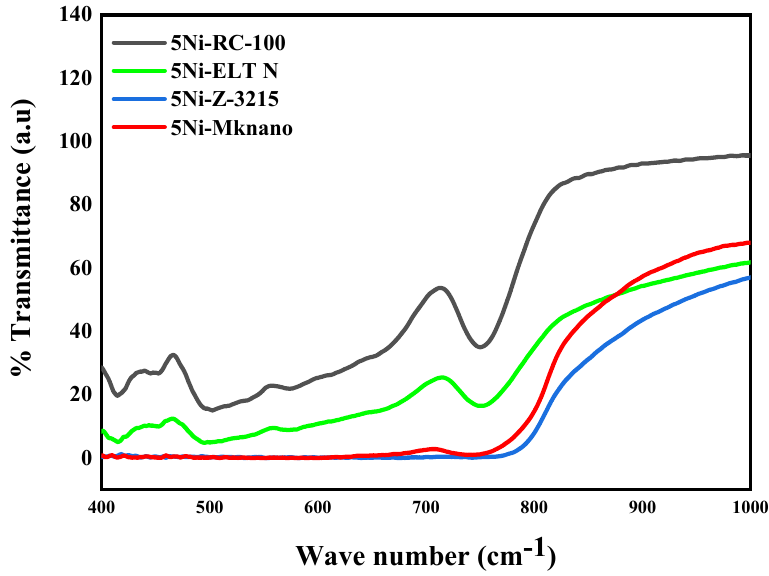
Figure 4. Comparison of FT-IR spectra of Ni catalysts supported on different sources of zirconia.